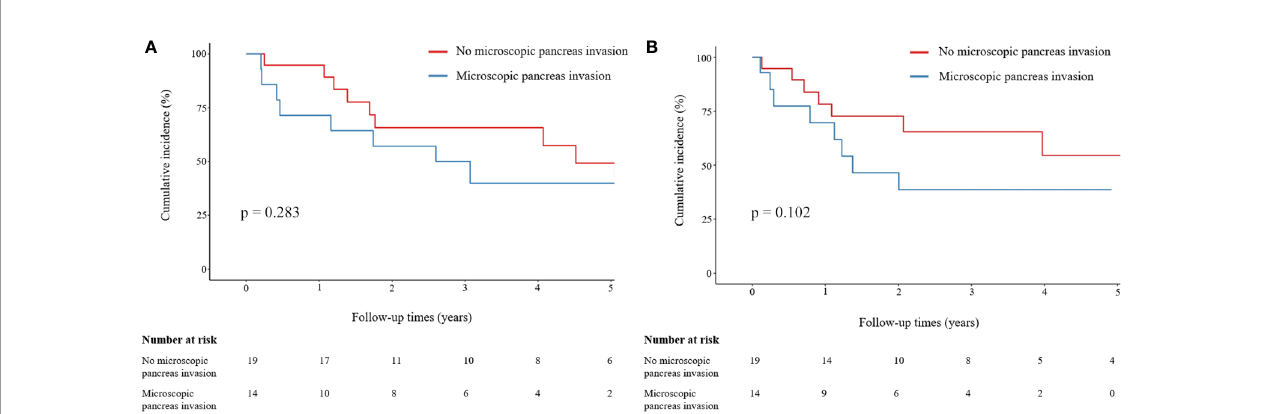
FIGURE 3 | Comparison of OS and LRFS rates between patients with and without microscopic pancreatic invasion. (A) Comparison of OS between patients with and without microscopic pancreatic invasion. (B) Comparison of LRFS between patients with and without microscopic pancreatic invasion. Group comparisons were performed using Kaplan – Meier and log-rank tests. OS, overall survival; LRFS, local recurrence-free